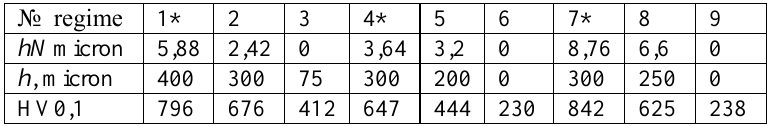
Thickness of nitride hN, diffusion layers h and surface microhardness HV0.1 №